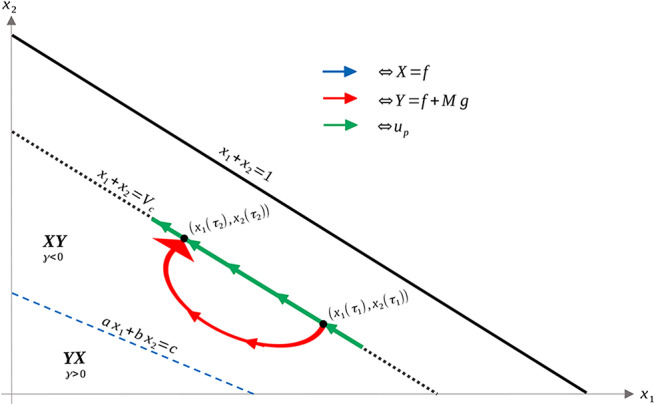
Comparison of upYup arc and an arc that remains on N (hence u ≡ up) between the points [S(τ1), R(τ1)] and [S(τ2), R(τ2)], assuming that up remains feasible (that is, up ∈ [0, M]). Note that γ < 0 in the area of interest, and that a switching of a Y to an X arc is prohibited via the Maximum Principle. Thus, the only possibility is the curve illustrated, which leaves the boundary N for a Y arc before up becomes infeasible.